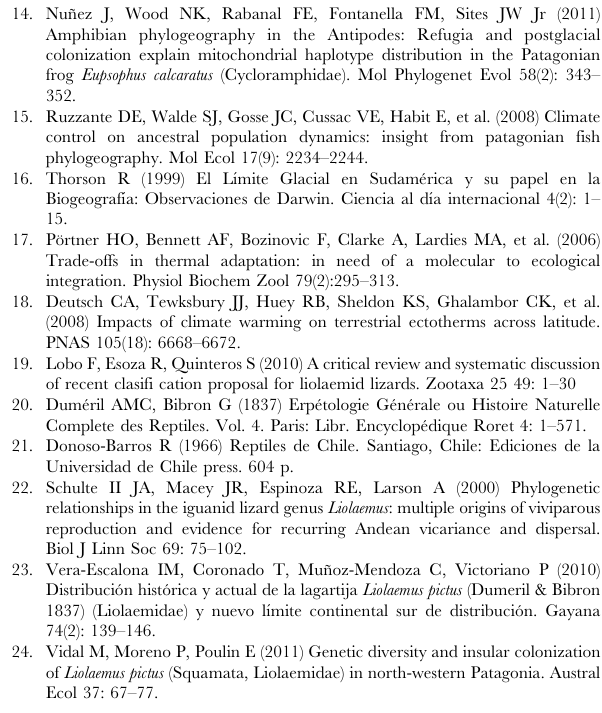
Table S2 Haplotypes composition for each sample site for the mitochondrial region cyt-b and the nuclear genes LDB5B and EXPH5 in Liolaemus pictus . Bold numbers are haplotypes distributed in more than one locality. Geographic coordinates and relative distribution of each locality are detailed in Table S1 and Fig. 1. Table S3 Analysis of molecular variance (AMOVA), for the two main haplogroups in Liolaemus pictus . Each